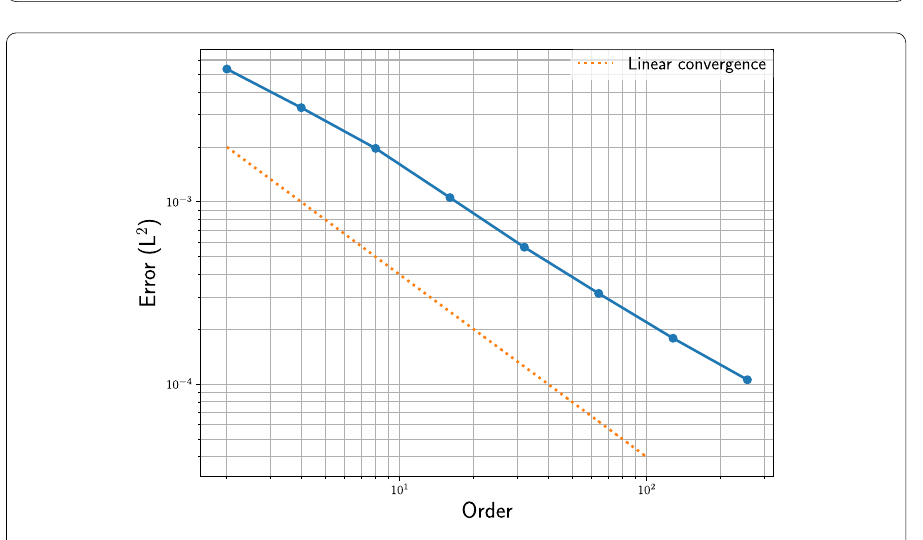
Fig. 5 L 2 -error for 12 elements over increasing maximal polynomial degree (p-refinement)